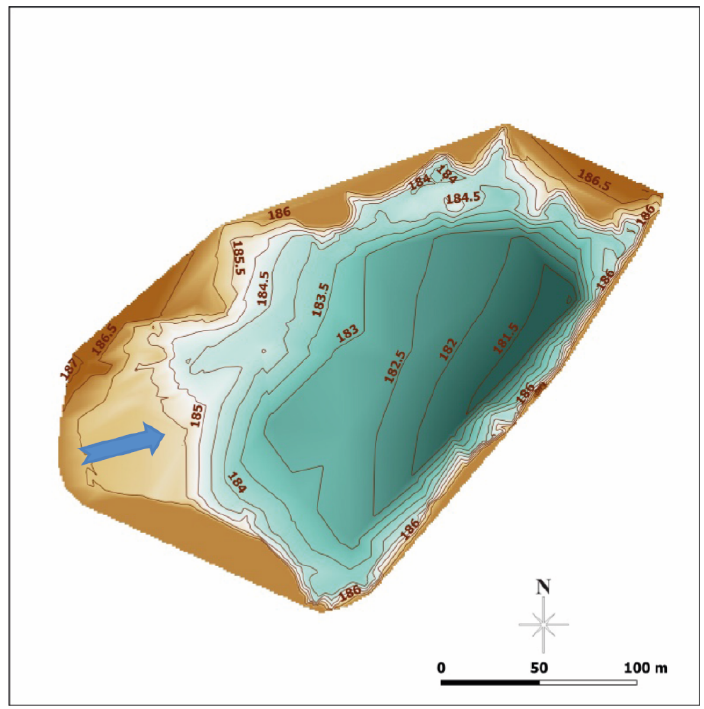
Figure 3. Map showing the original topography of the reservoir area in 1958 following dam construction. Blue arrow indicates flow direction.